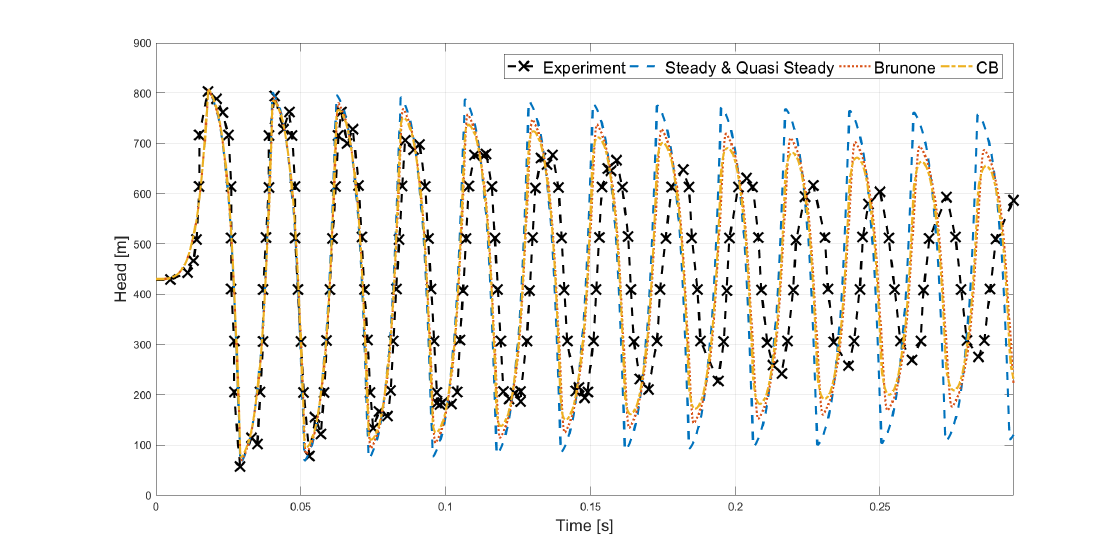
Figure 5. Comparison of the experimental data (experiment 1 [42]) with the simulated results for each friction model. Note that the steady and quasi-steady friction models gave similar results and all the Convolution Based models (CB) friction models also gave similar